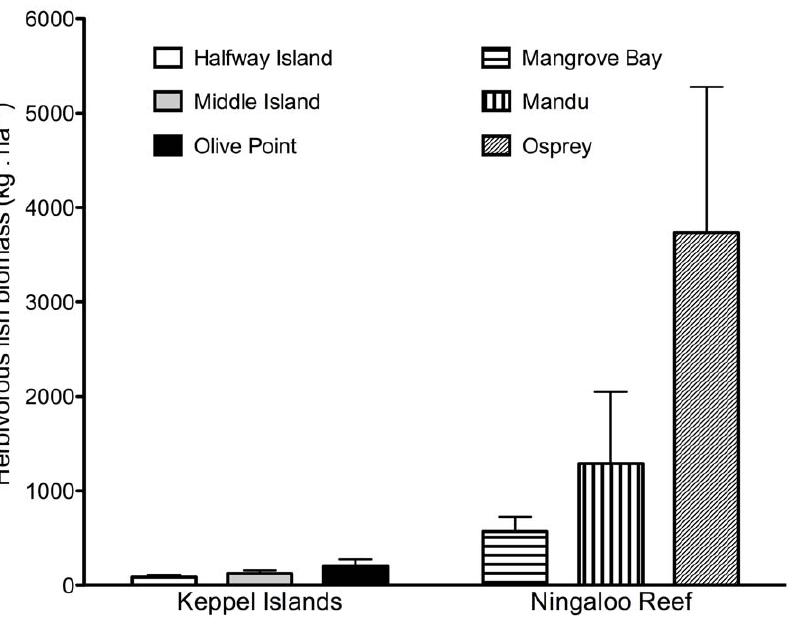
Figure 5. Variation between regions and locations in total roving herbivorous fish biomass (n=6). Sites were not significantly different from each other and have been